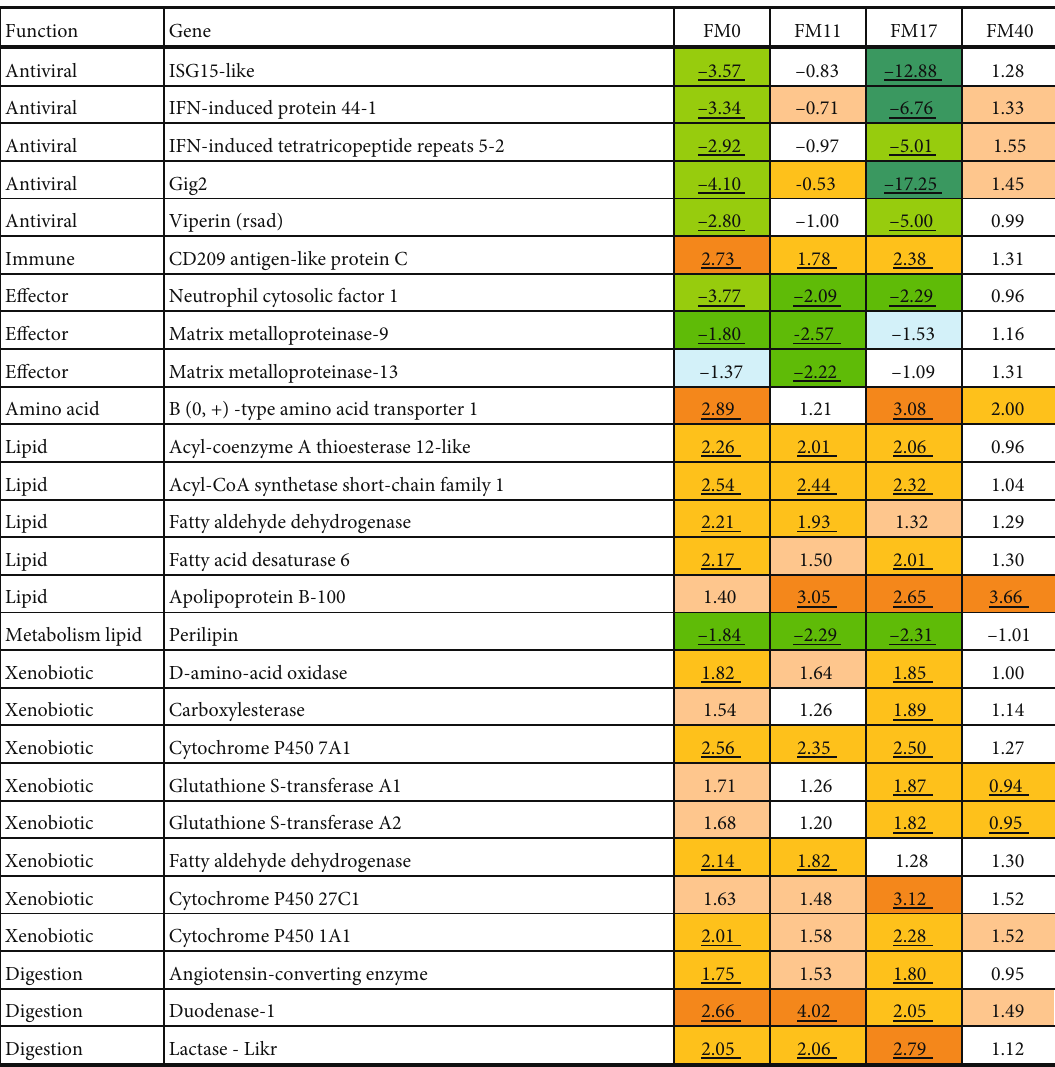
Figure 15: E ff ect of supplement on gene expression in distal intestine. Data are expression ratios (folds) of diets with and without supplement; di ff erential expression is marked with underlined bold